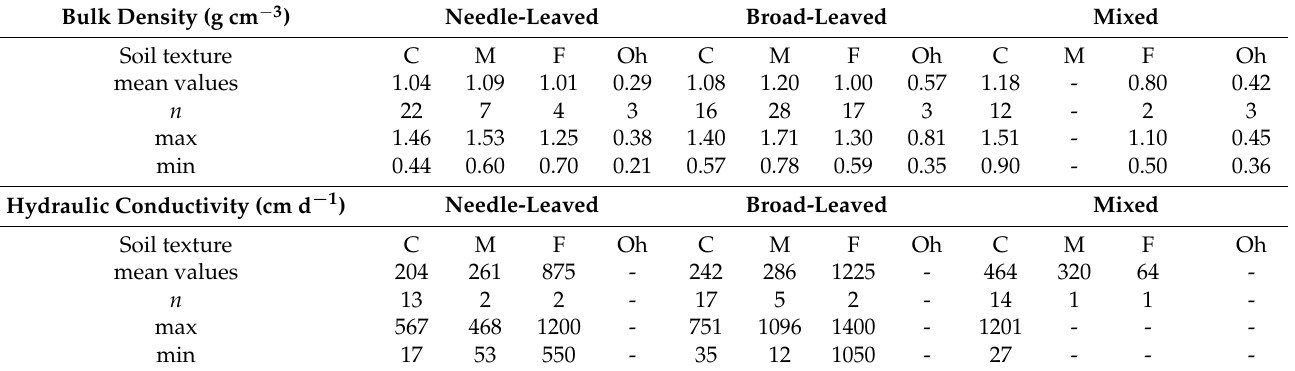
Figure 4. Descriptive statistics of the top mineral soil bulk density for dataset B in terms of forest type and soil texture: fine (clay-dominated), medium (mostly loamy), and coarse (mostly sandy). Scattered points represent the individual values between 0 and 30 cm soil depth, including the Oh-horizon. Grey points indicate the outliers. Table 5. Topsoil bulk density and hydraulic conductivity values in terms of forest type, filtered by soil texture. Letters C, M, and F stand for soils with coarse (mostly sandy), medium (mostly loamy), and fine (clay-dominated) soil texture, respectively, between 0 and 30 cm soil depth. In the case of bulk density, the letter Oh represents the values for the